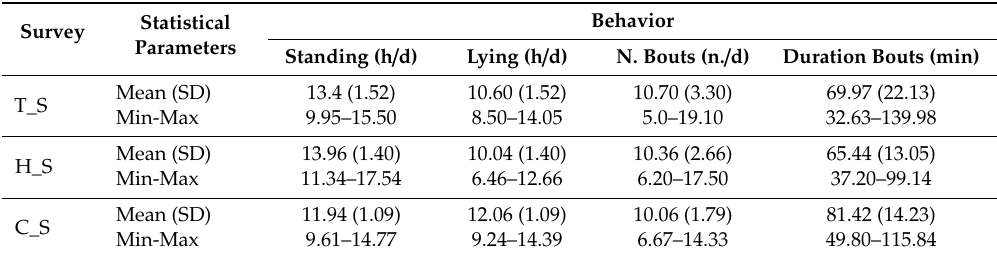
Table 3. Mean, standard deviation and minimum and maximum values of the eight farms for the behavioral results of lying and standing time (h / d), and of the number (n. / d) and duration (min / bout) of lying bouts. The “T_S” refers to thermoneutral climate, “H_S” to hot climate and “C_S” to cold climate. Survey Statistical